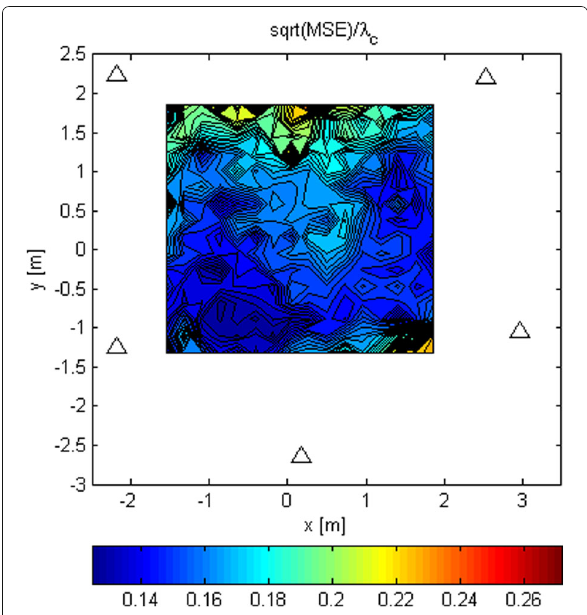
Fig. 16 RMSE/ λ c of stage 2 for G 2 and N = 1024 the grid should include the real Tx position. If the esti- mation errors have Gaussian distributions, the search grid for the next stage should span an area that is ± 2 standard deviations of the current stage along each dimension in order to include the real location with probability of 0.95.